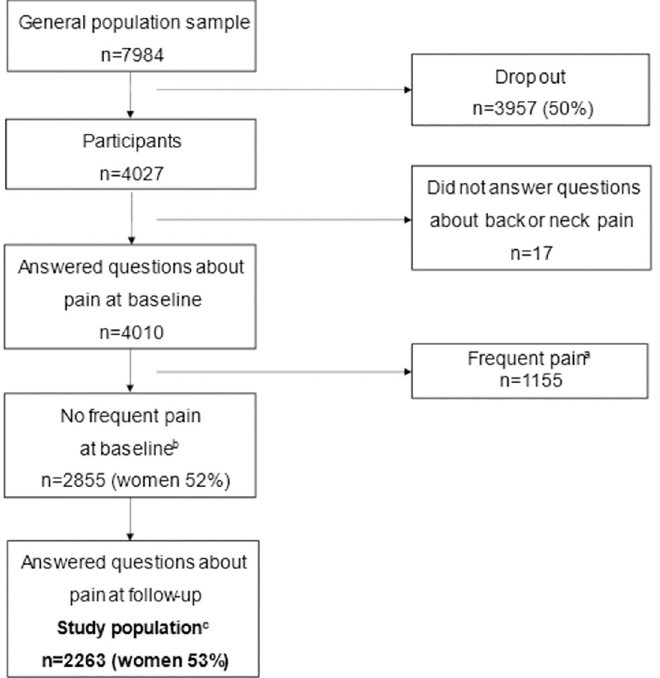
Fig 1. Flowchart showing the inclusion of the study population, a general population sample from the Swedish Health Assets Project (HAP). a pain nearly every day or now and again during the week, during the past twelve months, in the back or neck/shoulder. b pain now and again during the month or almost never or never, during the past twelve months, in the back or neck/shoulder. c individuals with no frequent pain at baseline who rated their pain in the back or neck/shoulder at